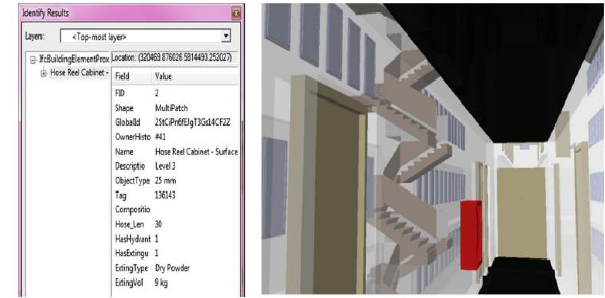
Figure 4. Location of indoor emergency utilities and their semantic information.